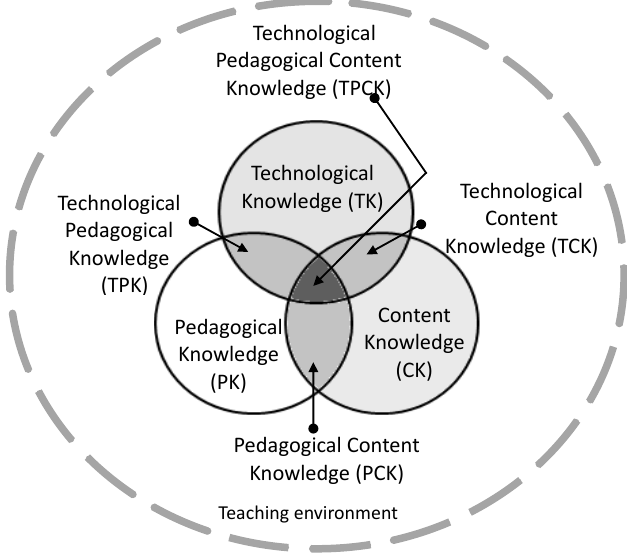
Figure 1. The TPCK framework (Mishra and Koehler, 2006).